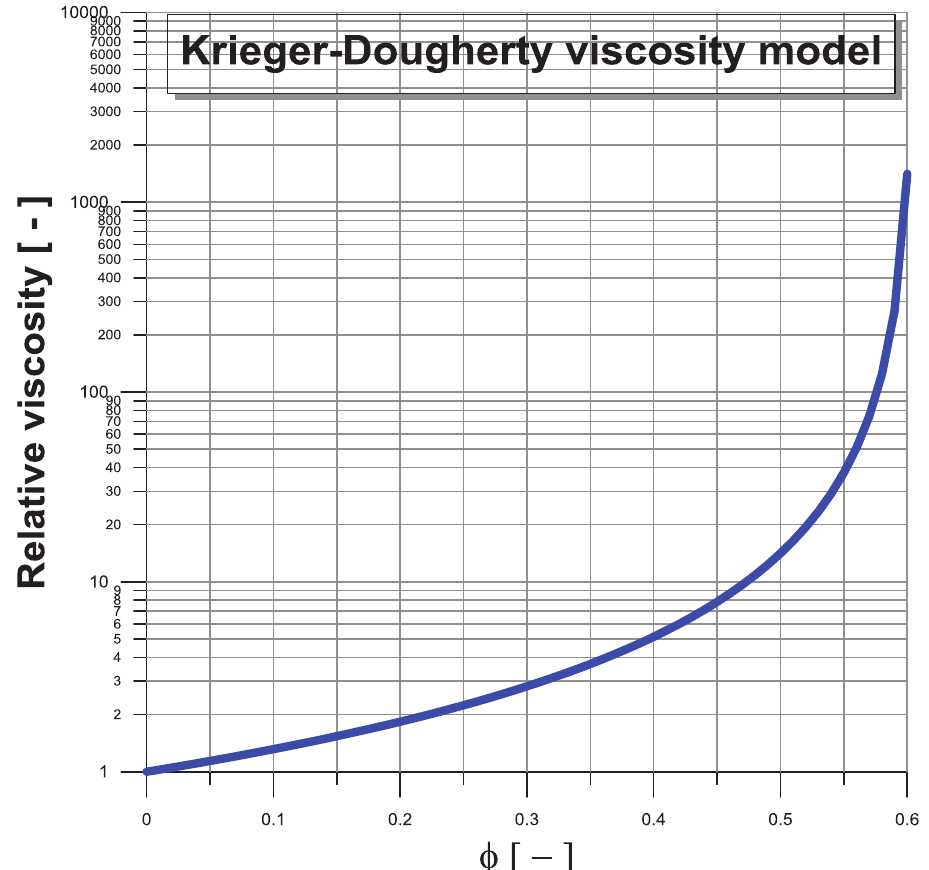
Fig. 3. Graphical representation of the Krieger-Dougherty viscosity model for a range of volume fraction and f m